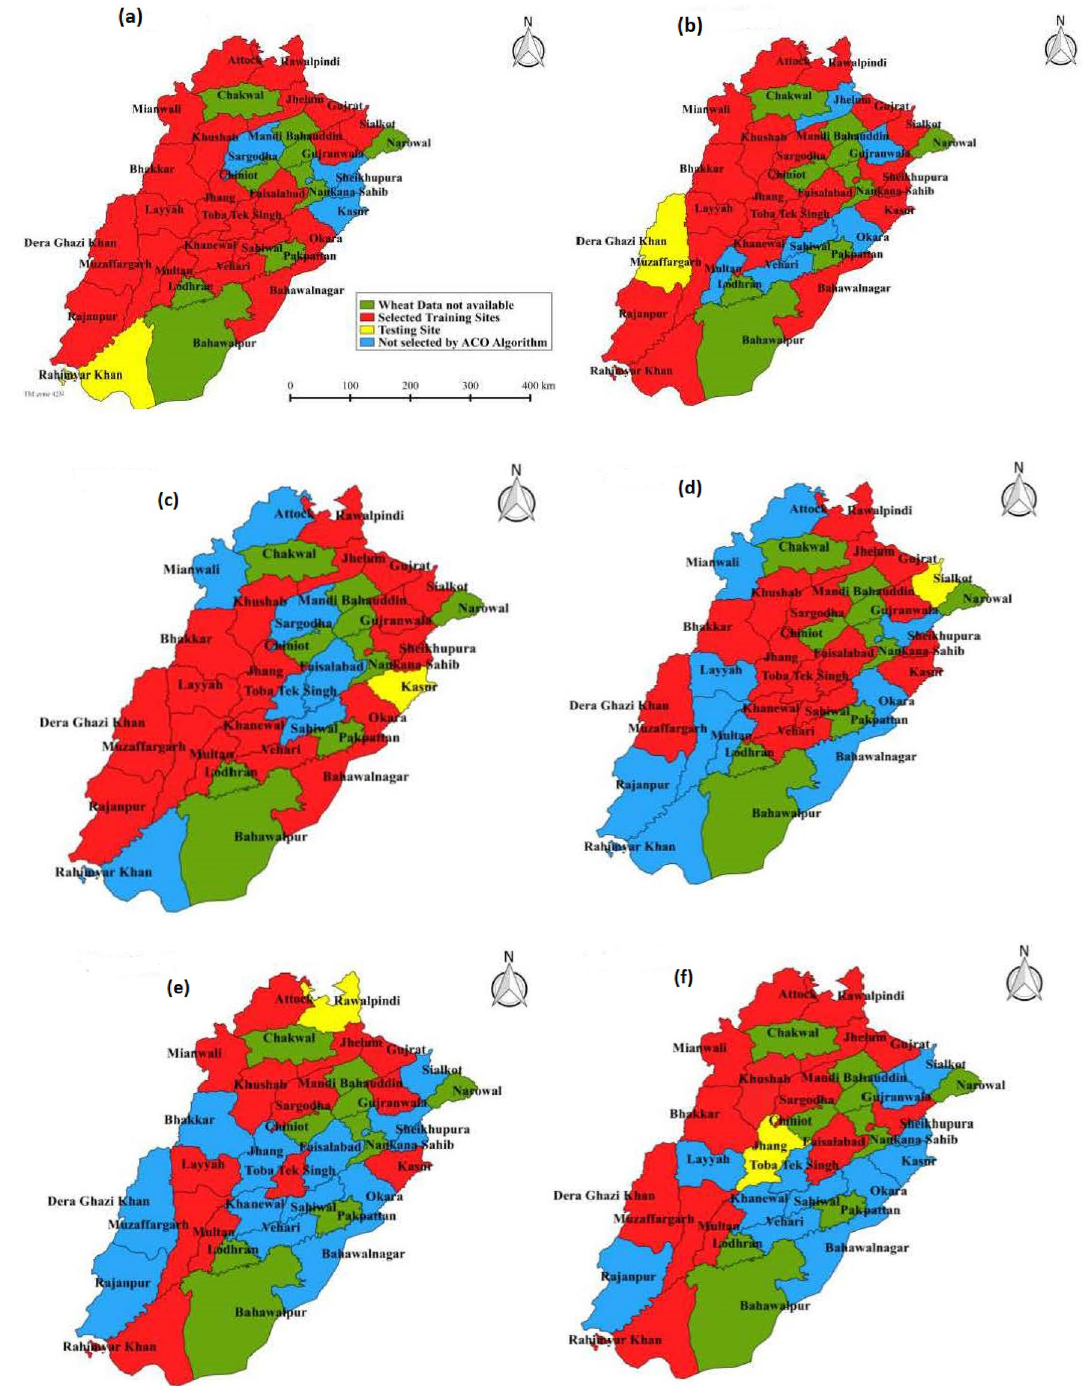
Figure 2. The selected training stations in red and the corresponding test stations in yellow are ( a ), ( b ), ( c ), ( d ), ( e ), and ( f ) respectively. Note that the stations shown in green have ‘no available wheat yield data’ and those in blue were not selected by the ant colony optimisation